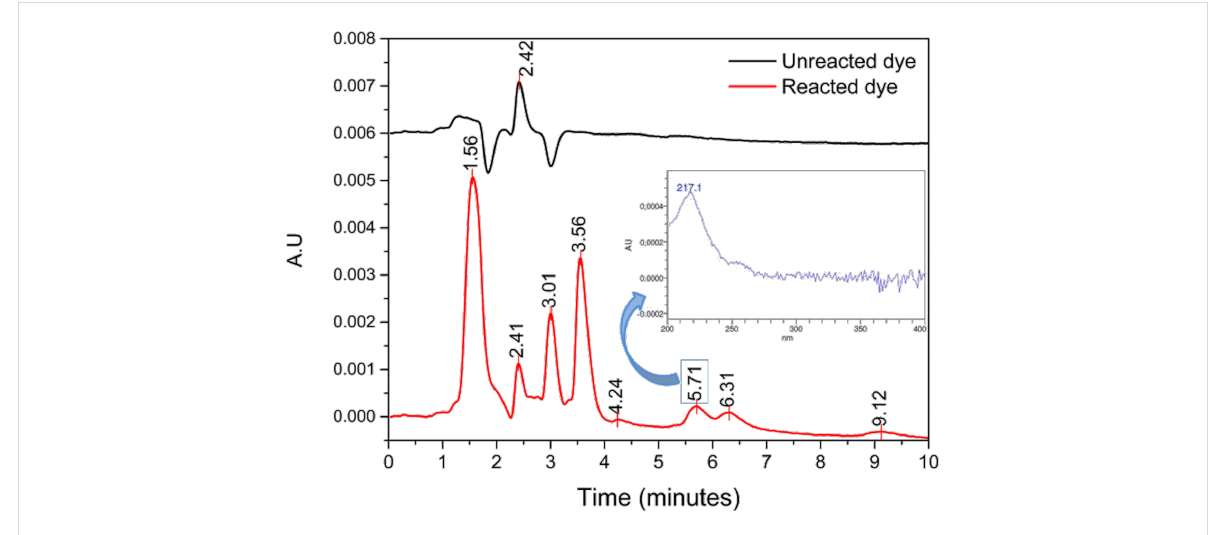
the efficiency of pyrite at breaking down the ring of CuPc, which we confirmed through the HPLC identification of sulfophthalimide, the most common oxidative byproduct of this dye [30]. Practical interest in pyrite as a Fenton- type reagent depends on its capability to efficiently and sustainably generate H 2 O 2 for oxidative degradation of contaminants. Figure 9 summarizes the proposed reaction mechanisms which are involved in the H 2 O 2 generation and in the subsequent degradation of CuPc by the hydroxyl radical